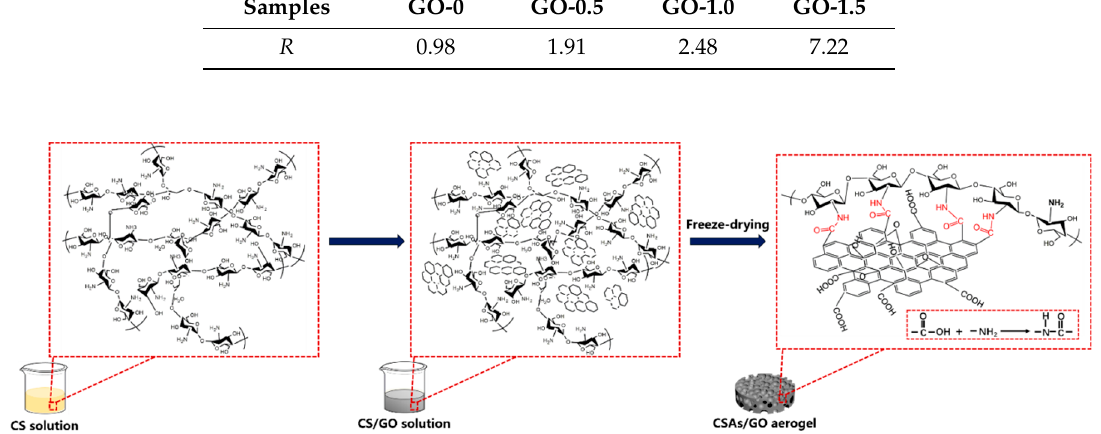
Figure 9. Mechanism diagram of reaction between GO and